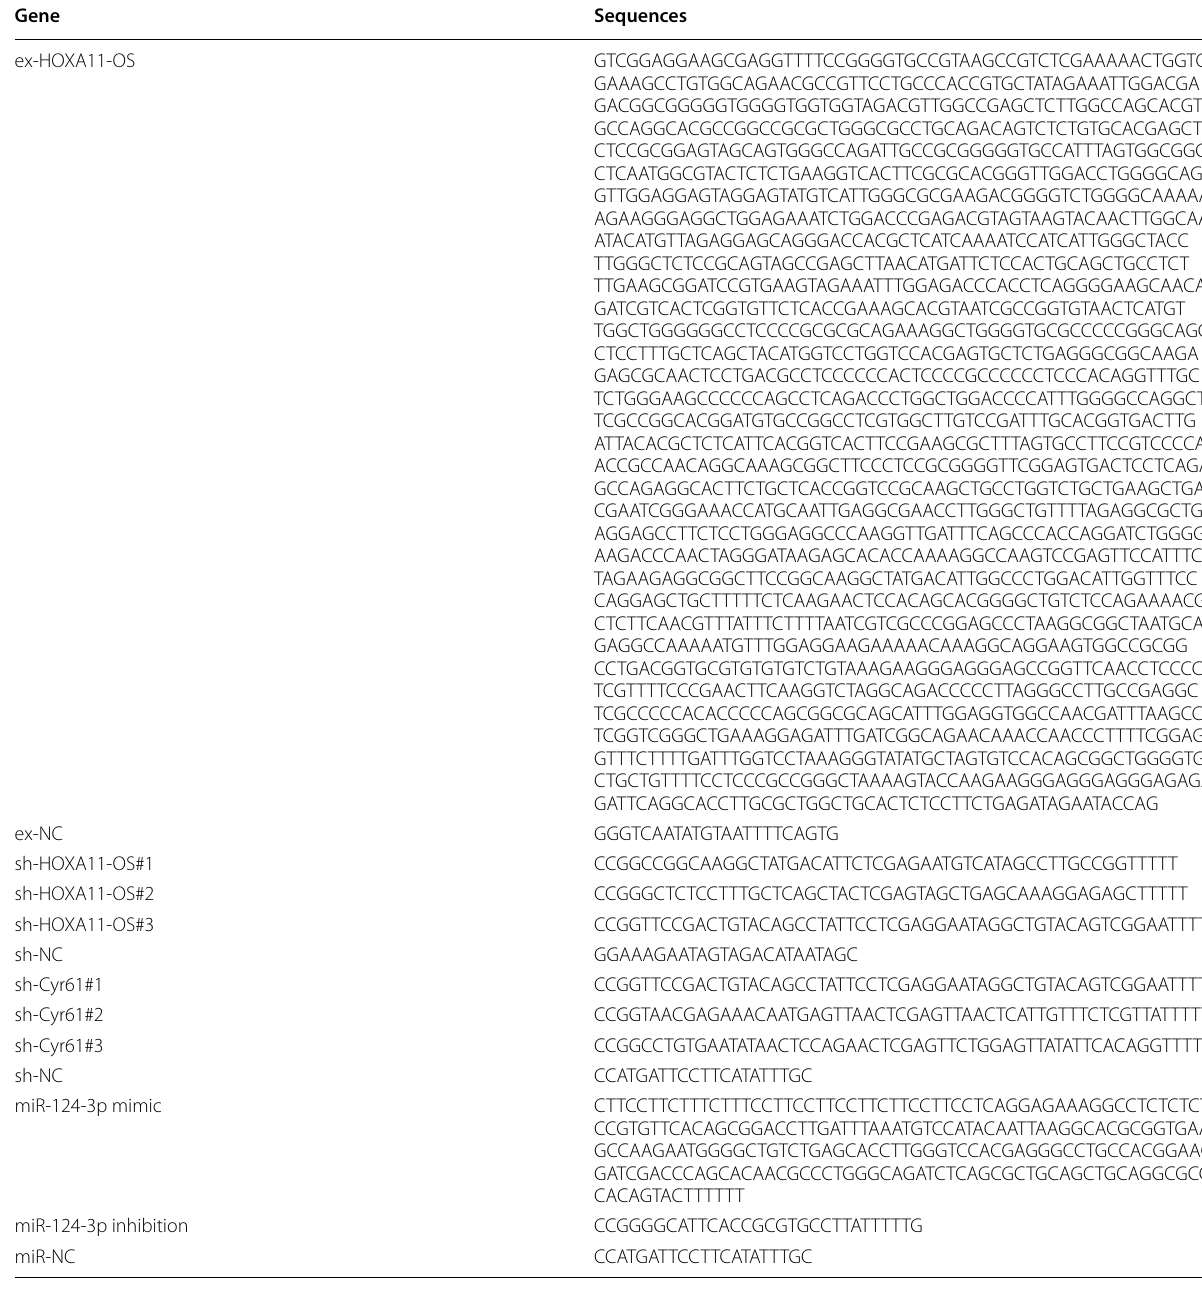
Table 2 Gene sequences used in cells experiments Gene Sequences